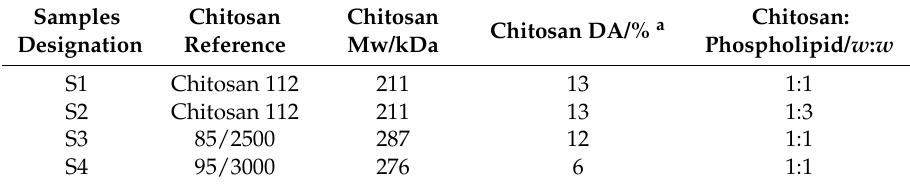
Table 6. Samples used in this